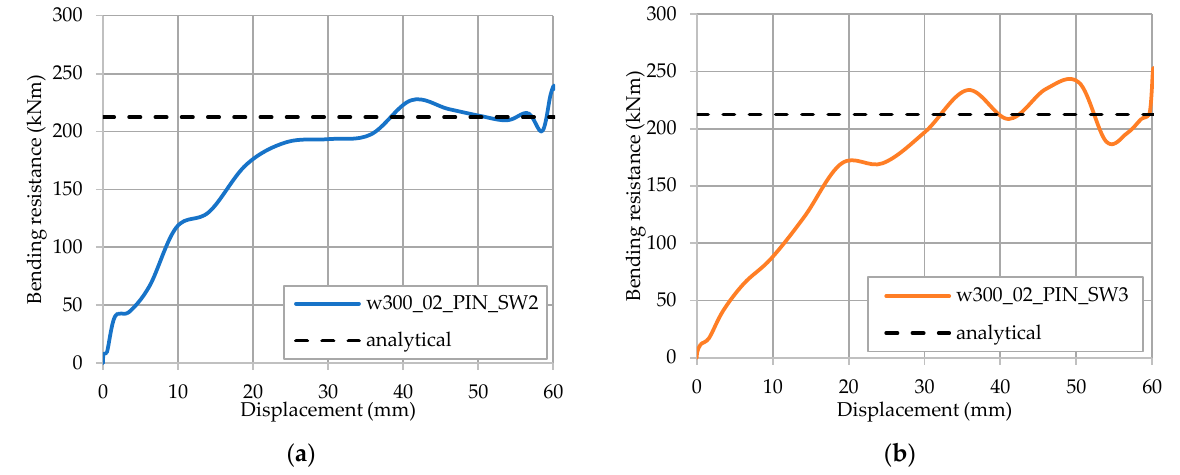
Figure 18. Bending resistance of the pinned beam for shear connectors spaced at 300 mm: ( a ) SW2; ( b ) SW3.